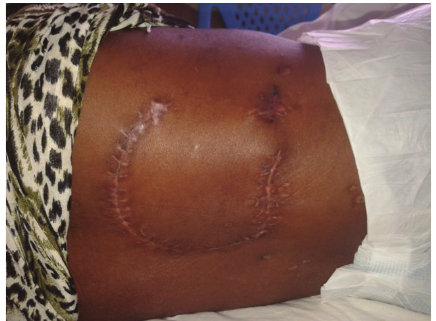
Figure 6: Wound fully healed 2 weeks after